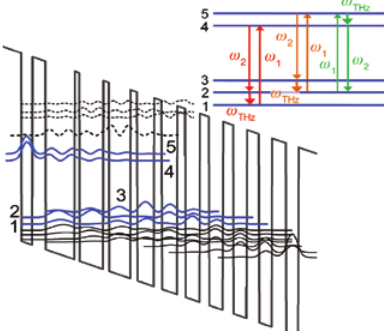
Figure 12: Schematic conduction band diagram and moduli squared of the relevant wave functions of the injector/active/injector parts in the active